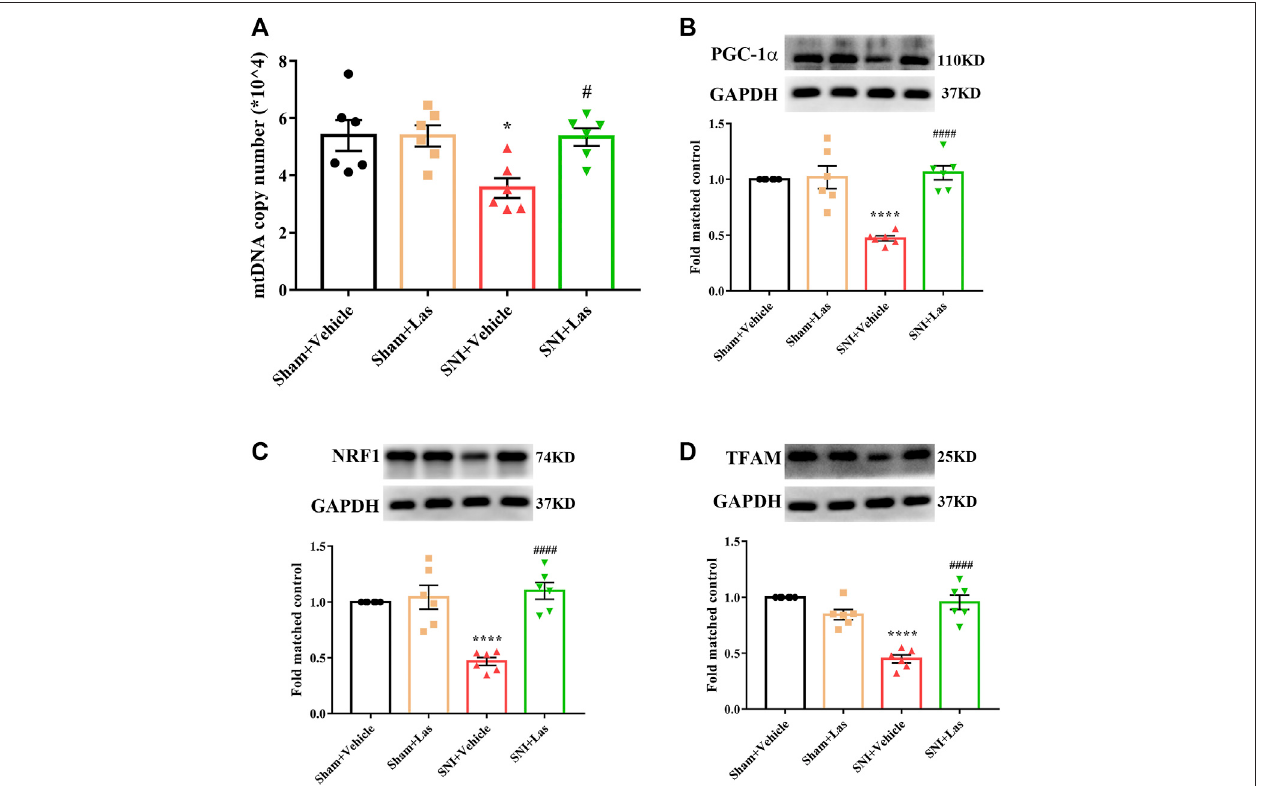
FIGURE 8 | Effect of 5-HT 1F receptor agonist on mitochondrial biogenesis in the spinal cord of neuropathic pain rats. (A) To determine whether 5-HT 1F receptor agonist affect mitochondrial biogenesis in SNI rats, lasmiditan (100 μ g, i. t.) was given once daily for fi ve consecutive days starting from day 7. Two hours after the fi nal administration, the L4 – 6 spinal cord was collected. The mtDNA copy number was signi fi cantly downregulated in SNI rats, which was reversed by Lasmiditan treatment (* p < 0.05, compared with Sham + Vehicle group, # p < 0.05 compared with SNI + Vehicle group, n = 6 in each group). (B) The protein level of PGC-1 α was signi fi cantlydownregulatedinSNIrats,whichwasreversedbylasmiditantreatment(**** p < 0.0001comparedwithSham+Vehiclegroup, #### p < 0.0001comparedwith SNI + Vehicle group, n =6 in each group). (C) The protein level ofNRF1 was signi fi cantly downregulated in SNI rats, which was reversed by lasmiditan treatment (**** p < 0.0001 compared with Sham + Vehicle group, #### p < 0.0001 compared with SNI + Vehicle group, n = 6 in each group). (D) The protein level of TFAM was signi fi cantly downregulated in SNI rats, which was reversed by lasmiditan treatment (**** p < 0.0001 compared with Sham + Vehicle group, #### p < 0.0001 compared with SNI + Vehicle group, n = 6 in each group).